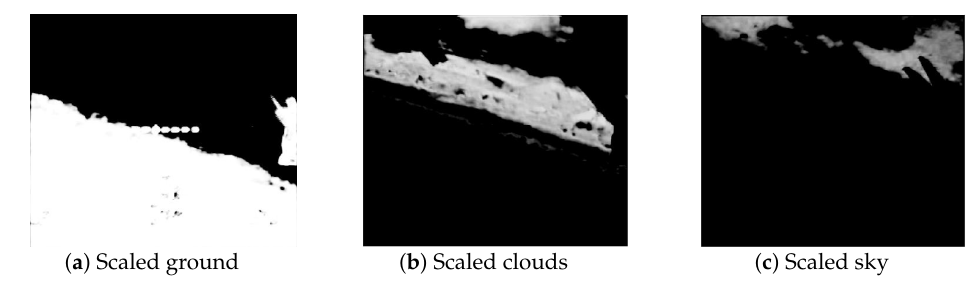
Figure 8. Pixel distribution for each class.